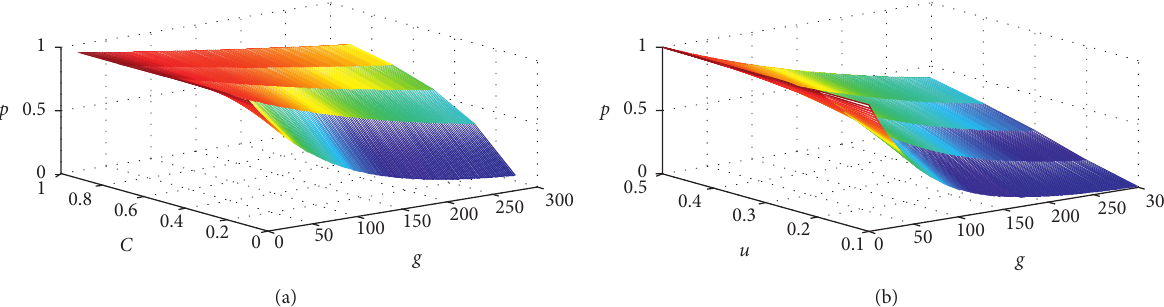
Figure 3: Variation tendency of the failure probability with the independent variables. (a) Station failure probability. (b) Line failure